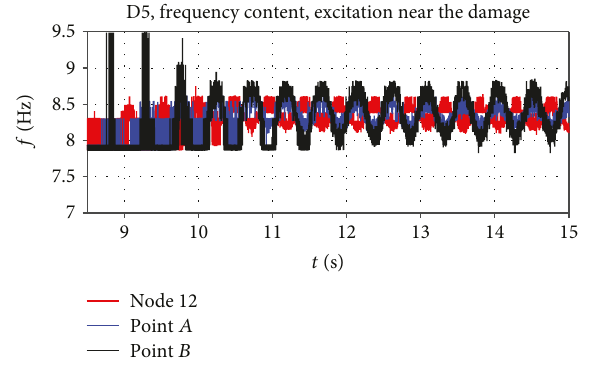
Figure 64: D5, maximum frequency, excitation near the damage.